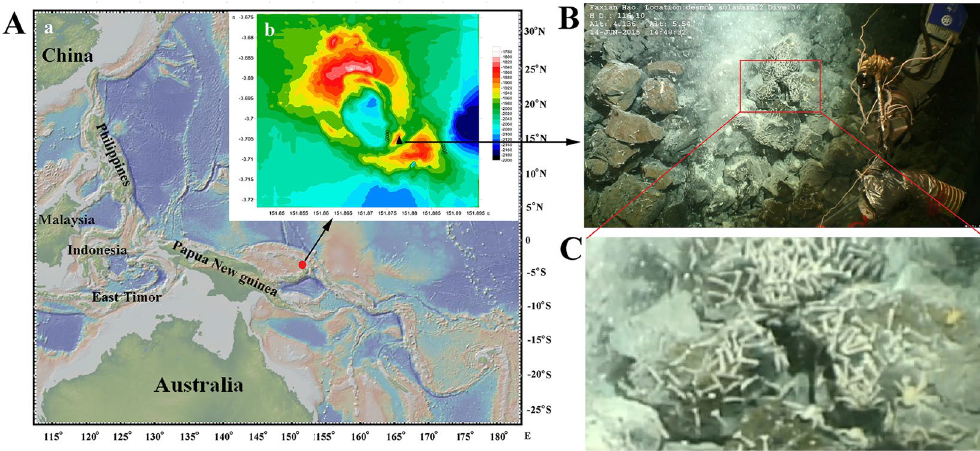
Figure 1. Location of the sampling site. (A) Location map of Desmos Manus basin (marked with “ ”) and the newly discovered hydrothermal site in the basin (marked with “ ” in Ab). Aa was generated with GeoMapApp version 3.6.0 (http://www.geomapapp.org) using Global Multi-Resolution Topography synthesis database, and Ab was generated using Surfer (Golden Software Inc., ver. 12.0) with the data obtained by the scientific